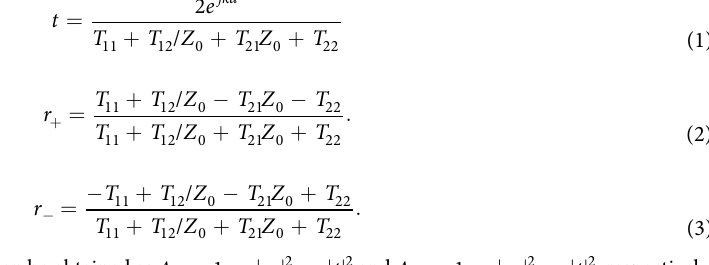
parallel-mounted MHRs and tube section. Here l is the distance between preposed MHR and the soft boundary. After some algebra, the pressure transmission and reflection coefficients are expressed as